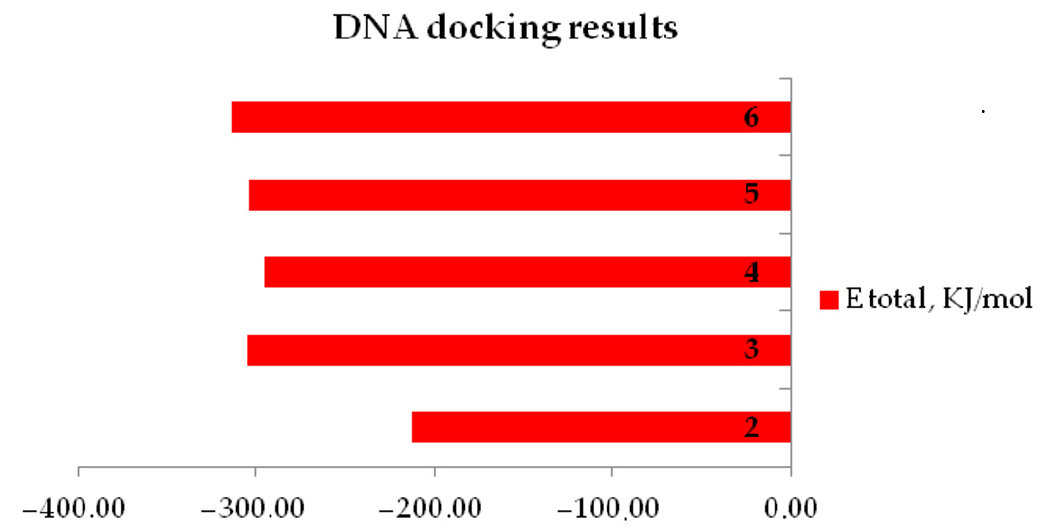
Figure 2. Results of docking compounds 2 – 6 with DNA.